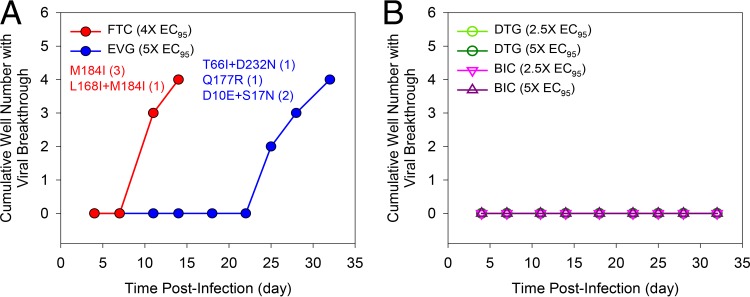
HIV-1 IIIb resistance breakthrough in MT-2 cells. Viral resistance breakthrough for each drug was tested in four independent infected cultures in the presence of constant drug pressure for up to 35 days. The number of cultures with replicating virus based on the observed cytopathic effect was scored at each time point. (A) Viral breakthrough control compounds included emtricitabine (FTC), tested at 4× EC95, and elvitegravir (EVG), tested at a Cmin of 5× EC95. (B) Dolutegravir (DTG) and bictegravir (BIC) also were tested at 2.5× and 5× EC95.